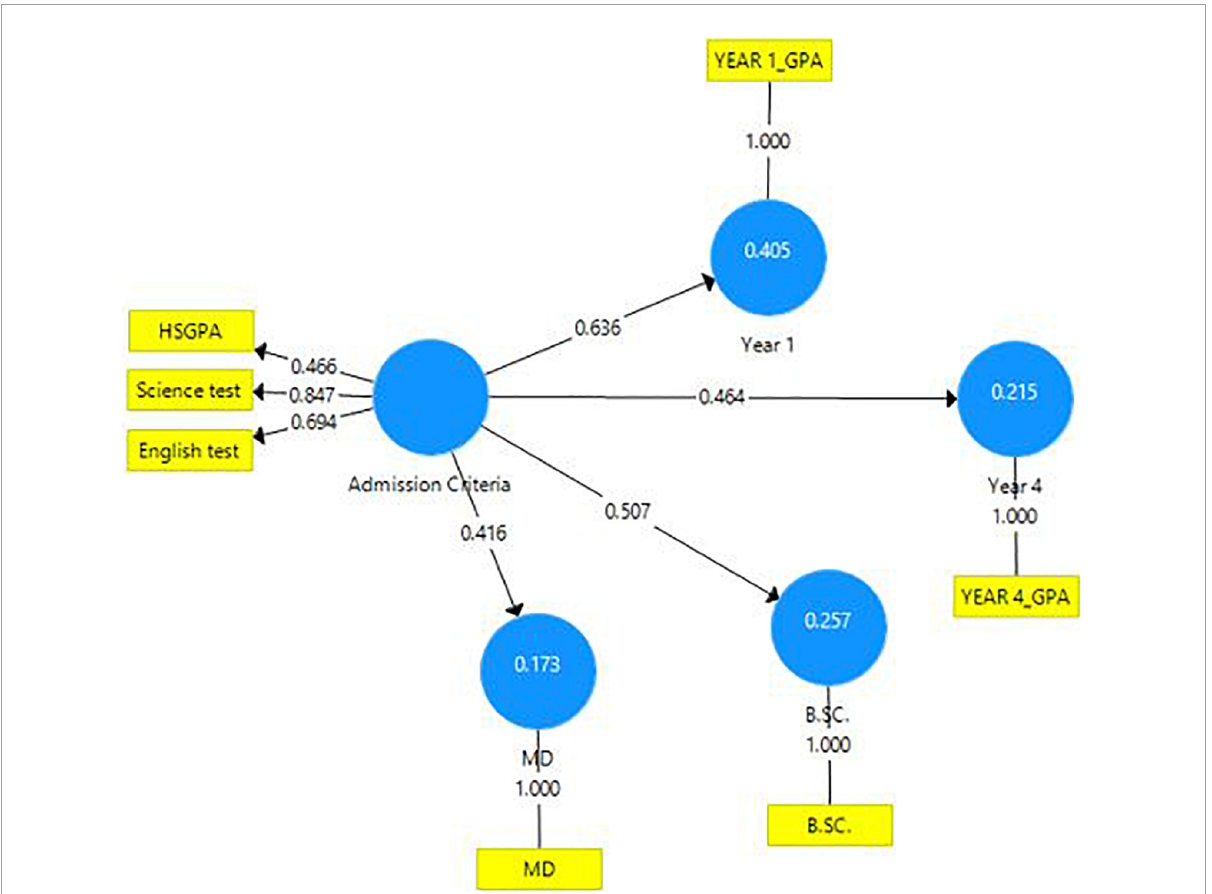
FIGURE1 Regression model for predicting academic performance according to admission